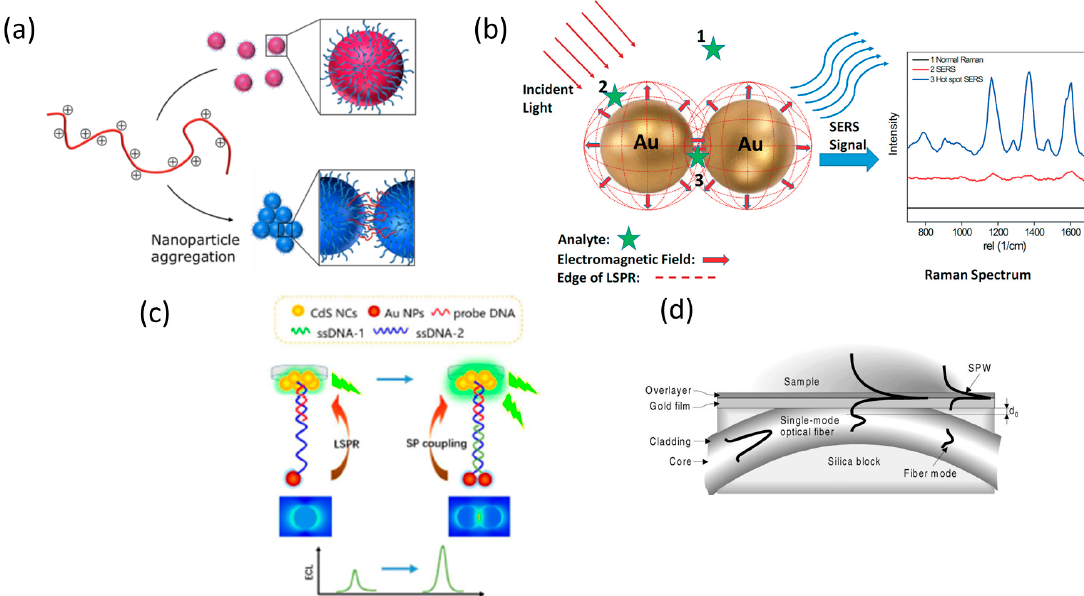
Figure 2. Schematic representation of plasmonic configurations: ( a ) Colorimetric assay showing dispersed (top) and aggregated (bottom) nanoparticles. Adapted with permission from Gormley et al. [28] Copyright © (2014) American Chemical Society (ASC). ( b ) Surface-enhanced Raman spectroscopy (SERS) phenomenon for an organic analyte on gold nanoparticles (AuNPs). Adapted with permission from Wei et al. [30] Copyright © (2015) RSC. ( c ) Schematic illustration of plasmonic-enhanced electrochemiluminescence (ECL) for DNA hybridization. Adapted with permission from Li et al. [31] Copyright © (2016) RSC. ( d ) Surface Plasmon Resonance (SPR) sensing structure based on a side-polished, single-mode fiber. Adapted with permission from Slav í k et al. [33] Copyright © (2001)